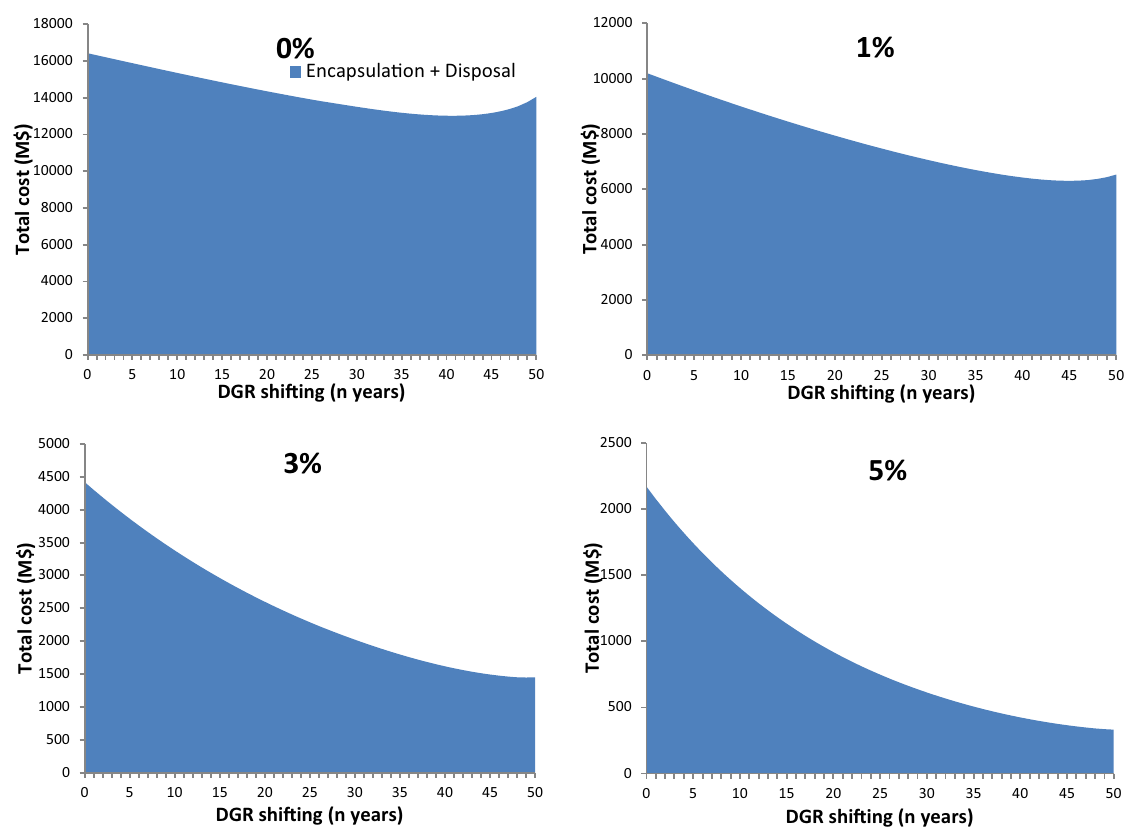
Fig. 11. Effect of reprogramming DGR deployment for n years while maintaining the initial closure